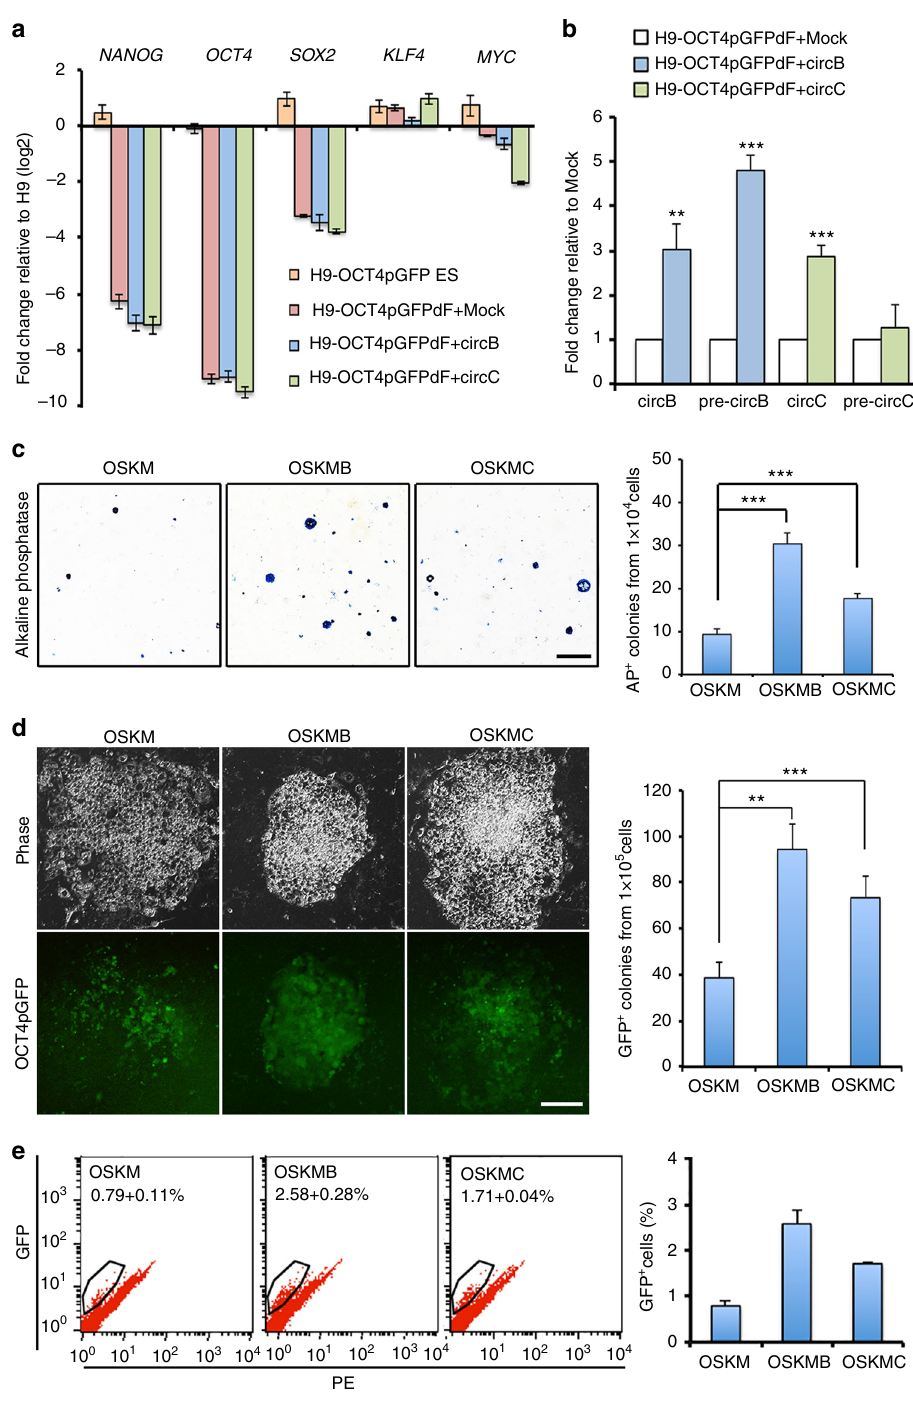
Fig. 4 CircBIRC6 or circCORO1C promotes reprogramming. a RT-qPCR analysis of the expression of the indicated pluripotency-associated genes in H9- OCT4pGFP, H9-OCT4pGFPdF, and H9-OCT4pGFPdF cells transduced with a circBIRC6 (H9-OCT4pGFPdF+circB) or circCORO1C (H9-OCT4pGFPdF+circC) minigene. b RT-qPCR analysis of the expression of circRNA and its precursor transcripts in H9-OCT4pGFPdF+circB and H9-OCT4pGFPdF+circC cells using primers speci fi c for the indicated circRNAs and circRNA precursors (pre-circB and pre-circC). c AP staining and quantitative analysis of AP + colonies among H9-OCT4pGFPdF cells transfected with OSKM or co-transfected with OSKM and circRNA minigenes (OSKMB and OSKMC). Scale bar: 400 μ m. d Reactivation of OCT4pGFP in H9-OCT4pGFPdF cells and quantitative analysis of OCT4pGFP + colonies of H9-OCT4pGFPdF cells transfected with OSKM or co-transfected with OSKM and circRNA minigenes (OSKMB and OSKMC) 21 days post transduction. Scale bar: 50 μ m. e Quantitative FACS analysis of OCT4pGFP + cells in OSKM, OSKMB, and OSKMC 28 days post reprogramming. Quantitative data from three independent experiments is presented as mean ± SD (error bars). P -values were determined by two-tailed two-sample t -tests (* P < 0.05; ** P < 0.01; *** P <